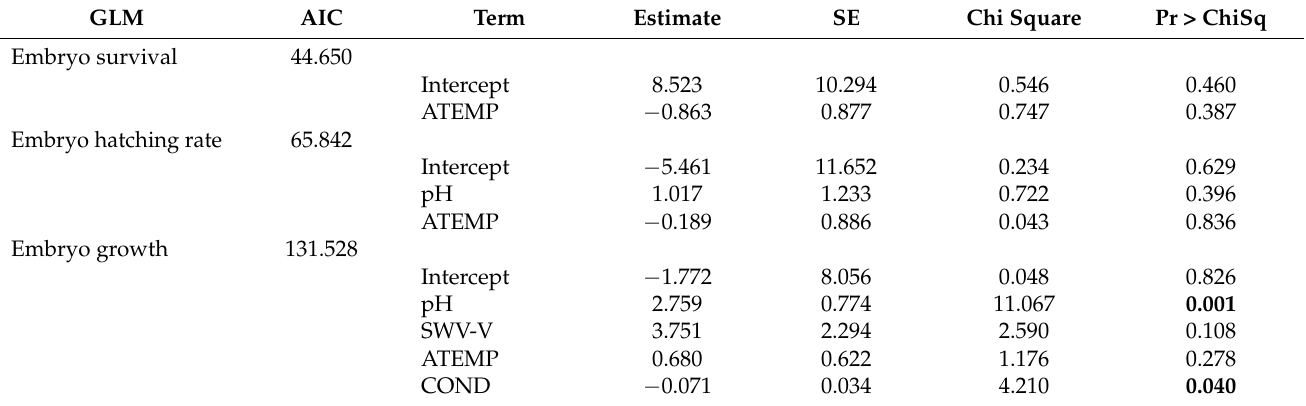
Table 6. Summary statistics from the final Generalized Linear Models (GLM) for Chinook salmon embryo survival, hatching rate, and growth on the lower Mokelumne River, based on physical and chemical habitat variables. Terms have been ordered by effect direction and strength showing estimated model coefficients, standard error (SE), chi square, and p -Values. The final model was selected based on the lowest AIC score. Term abbreviations are as follows: ATEMP = average daily temperature, SWV-V = surface water velocity (vertical), COND = conductivity. Pr > ChiSq = chi square test statistic. Bold indicates statistical significance ( p <